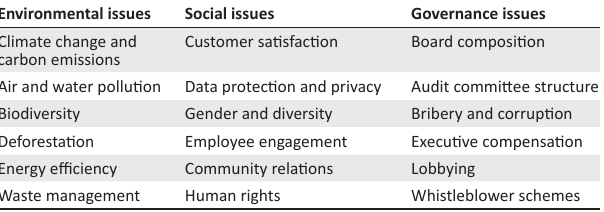
TABLE 1: Examples of environmental, social and governance (ESG) issues – often called the ESG